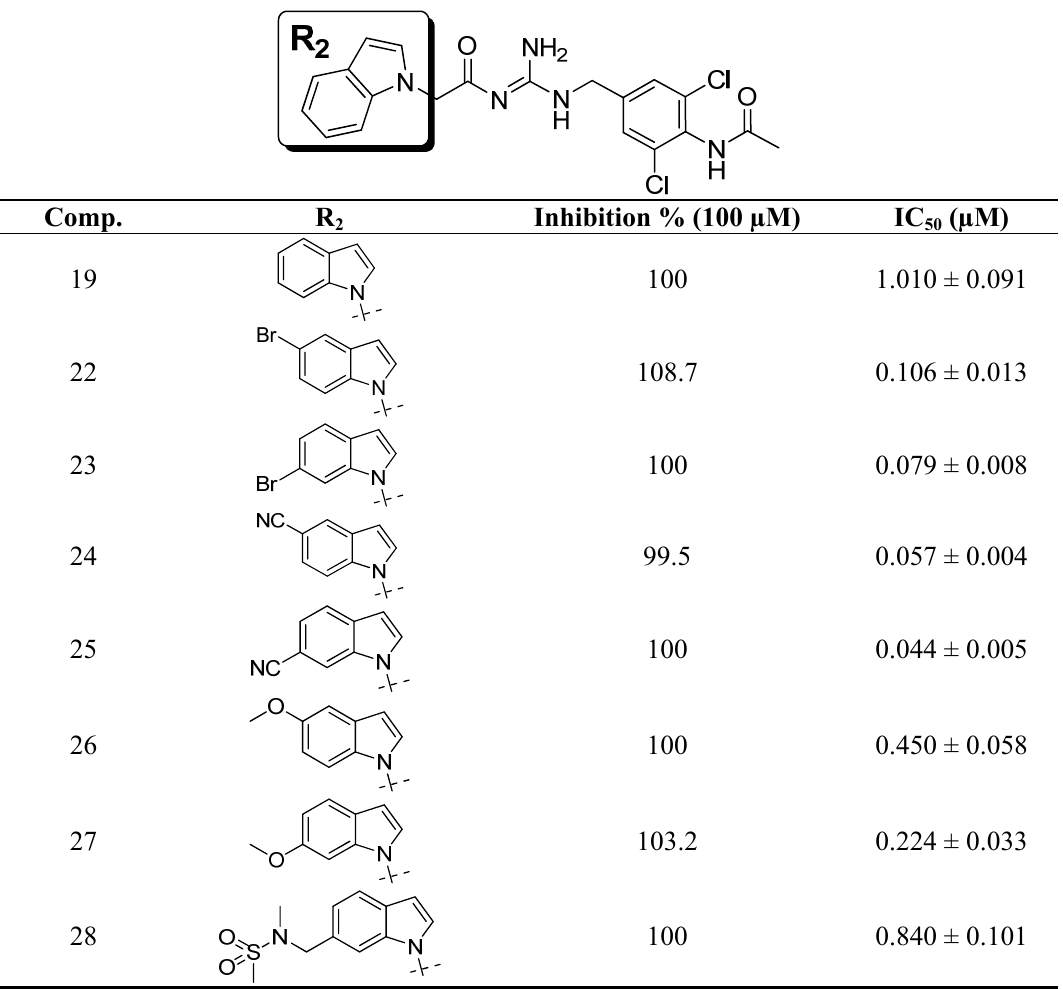
Table 2. BACE-1 inhibitory activities of compounds 22 – 28